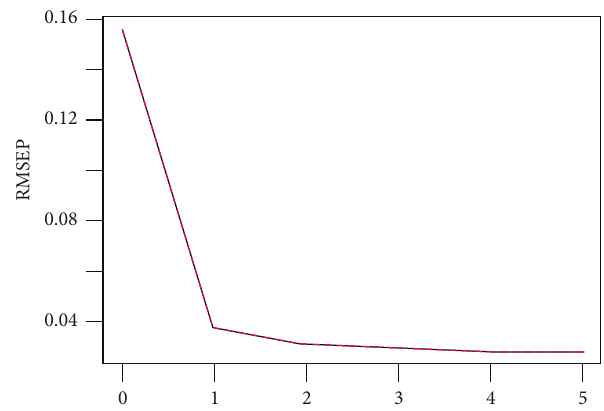
Figure 1: The sum of squares of errors corresponding to the number of principal